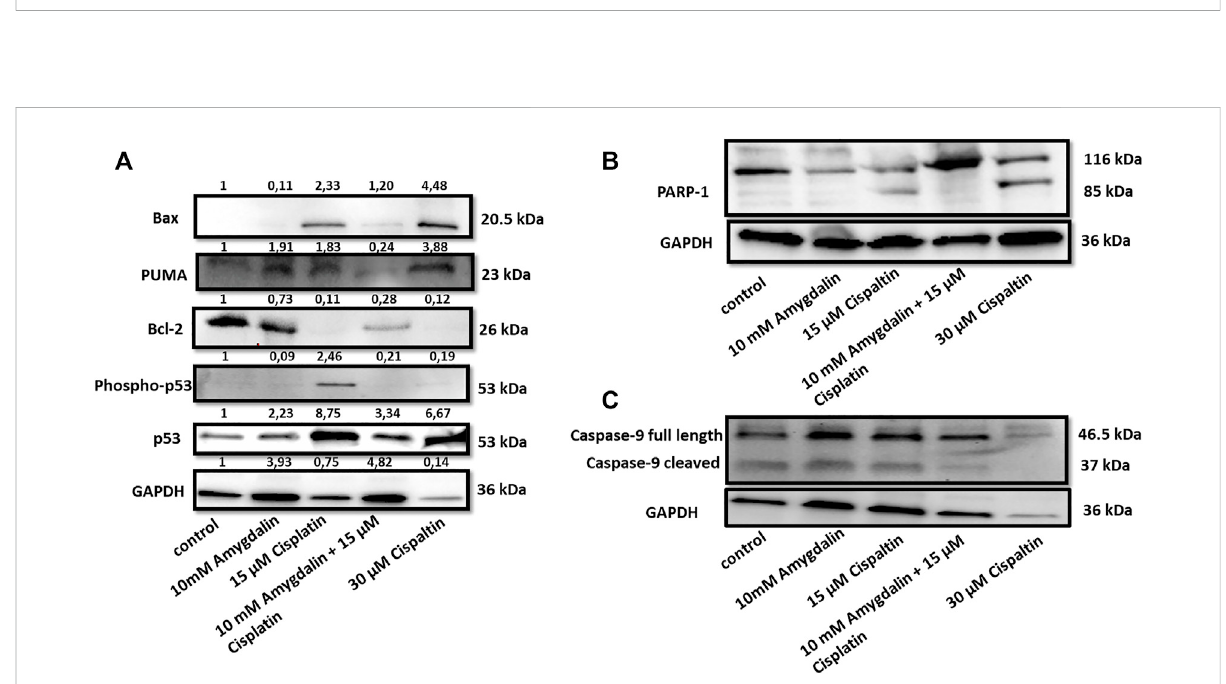
FIGURE 4 Effect of amygdalin and cisplatin on the levels and localization of apoptotic proteins in normal cells. (A) The combination of 10 mM amygdalin and 15 μ M cisplatin reduced the protein levels of Bax, phosho-p53, p53, PUMA and increased the protein levels of Bcl-2 following 48 h of treatment inMCF12F. (B) TheexpressionofcleavedPARPisshownundercisplatintreatment.Cisplatinalonecausedcleavageofcaspase-9while (C) amygdalin (10 mM) reduced this effect. The intensity values from the densitometry analysis of Western blots are shown on the top of each blot and were normalized against GAPDH using ImageJ software. The results are representative of at least three independent